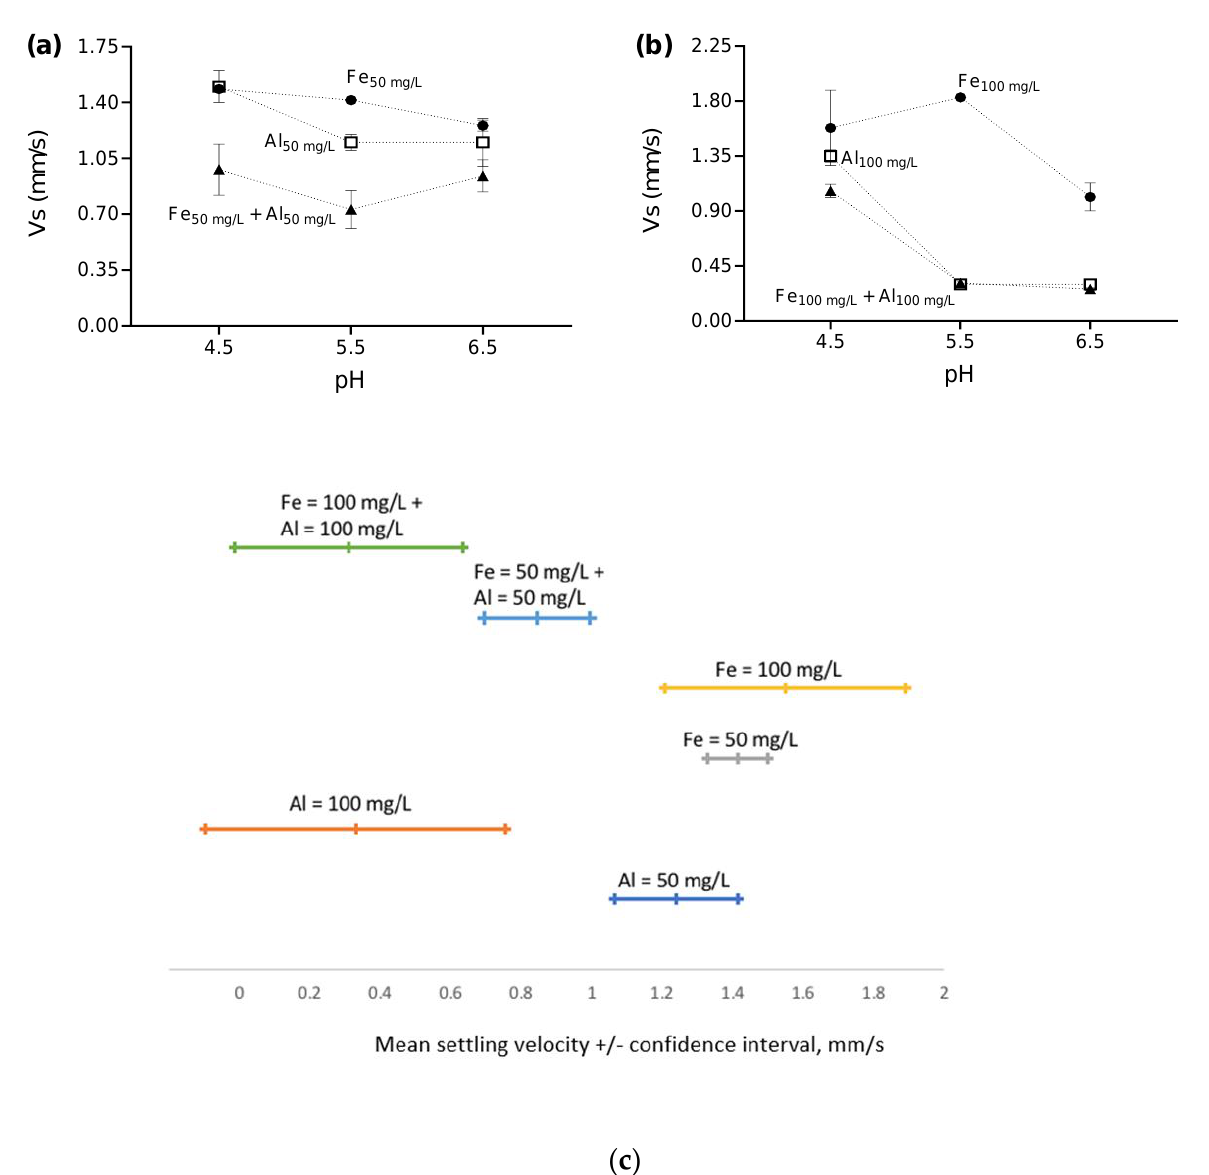
Figure 2. Settling velocity of the interface (Vs: mean and range) at the three pH levels evaluated. ( a ) Suspensions with metal concentrations of 50 mg/L. ( b ) Suspensions with metal concentrations of 100 mg/L. ( c ) Confidence intervals with α = 0 .05.